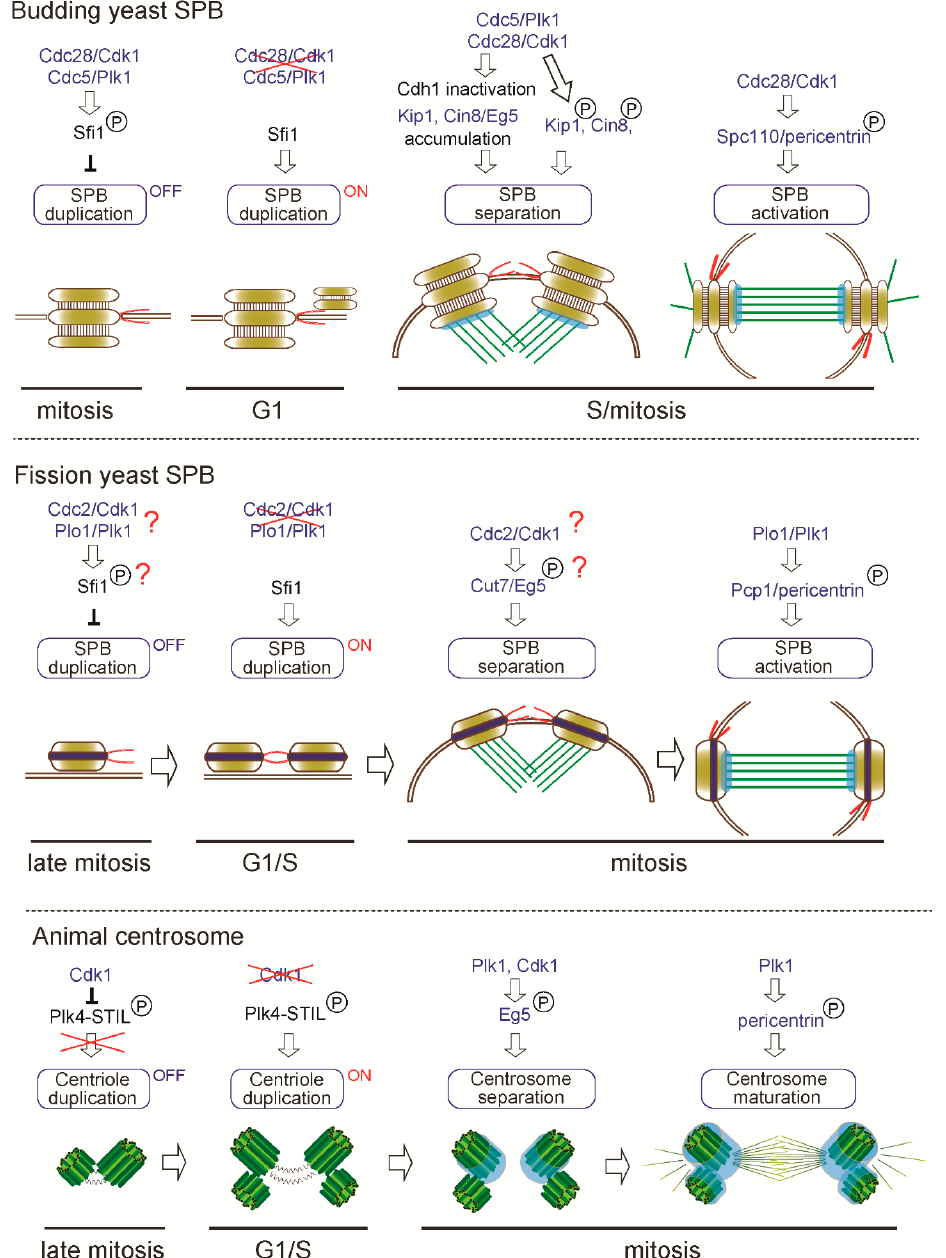
Figure 3. Common regulators of centrosome biogenesis and function. Similar regulators are involved in centrosome biogenesis: (1) duplication; (2) separation and (3) maturation/activation in yeasts and animals.